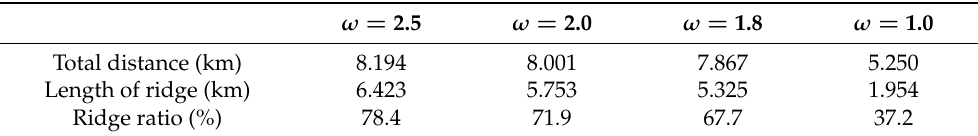
Table 2. Data comparison of RA* without safety map.